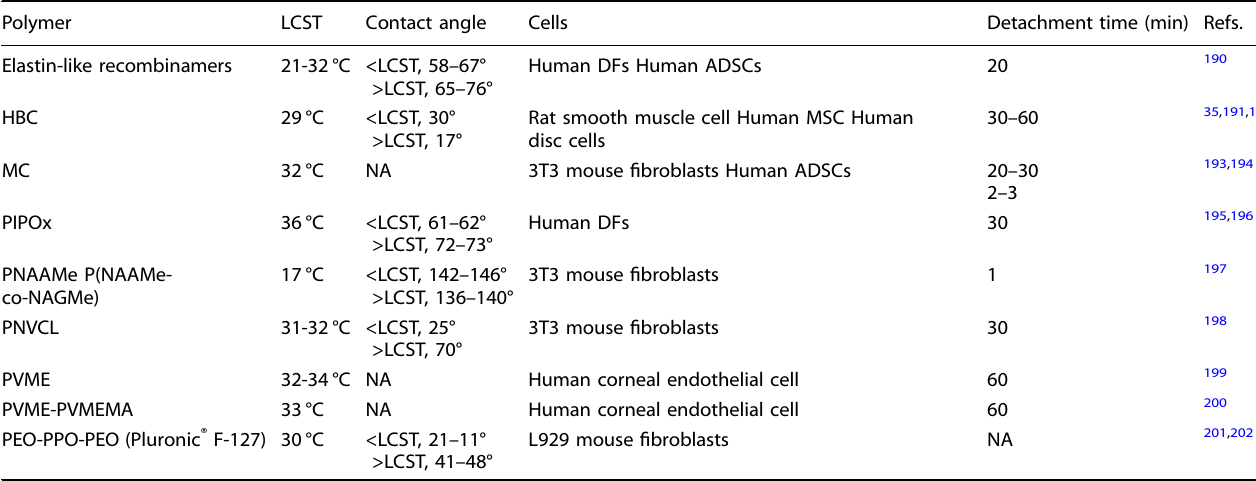
Table 3. Temperature-responsive polymers that have been used in the development of scaffold-free cell sheet.